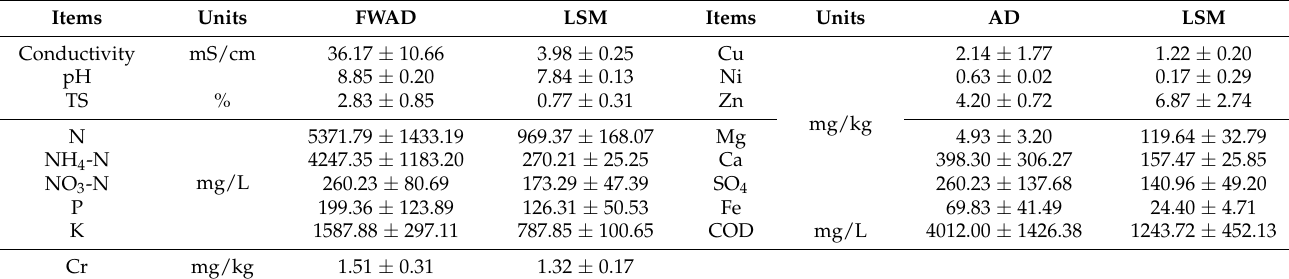
Table 1. Physiochemical parameters of the food waste anaerobic digestate (FWAD) and liquid swine manure